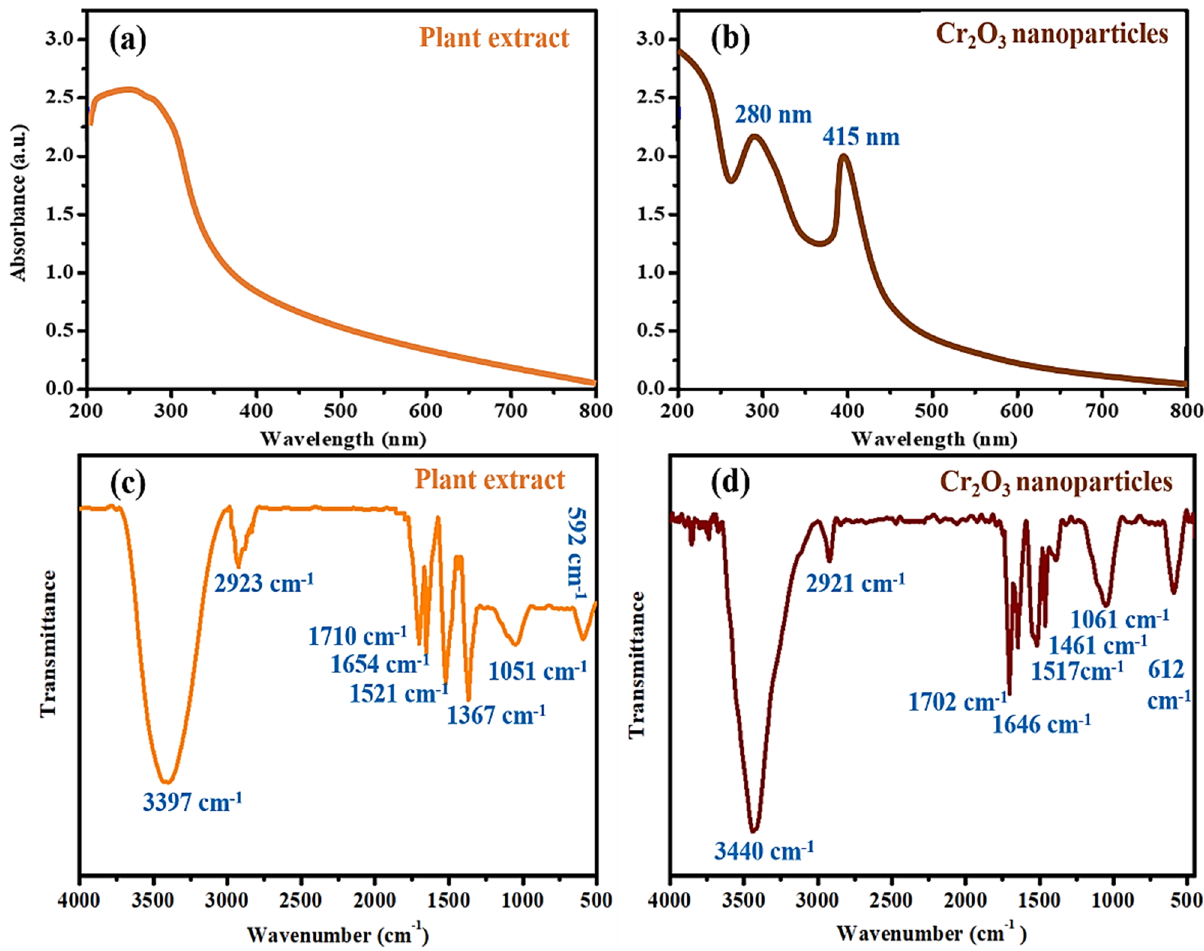
Figure 2. UV–Visible spectra of ( a ) plant leaf extract, ( b ) Cr 2 O 3 nanoparticles. FTIR of ( c ) plant extract and ( d ) Cr 2 O 3 nano-